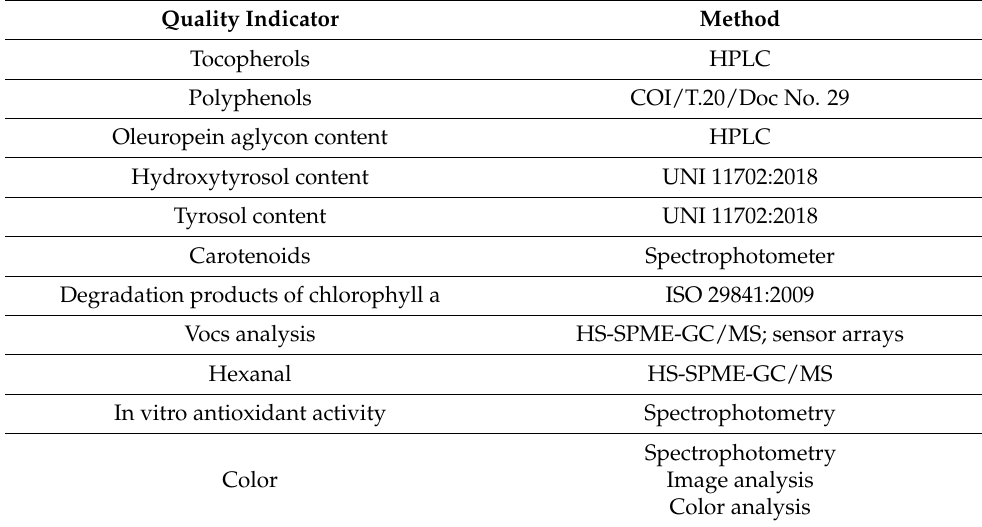
Table 3. Non-compulsory indices which can be assumed as markers to track the evolution of the oxidative degradation of virgin olive oils during storage and relevant analytical methodologies